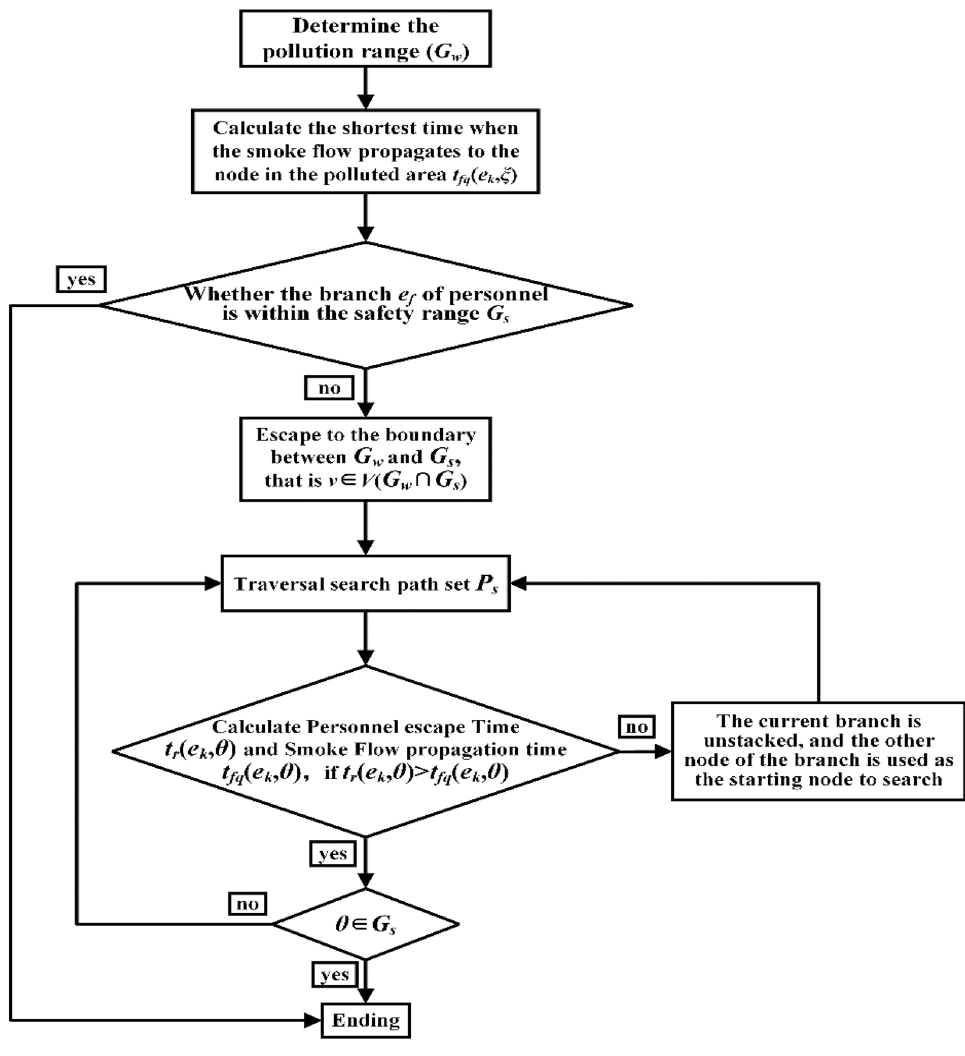
Figure 1. Numerical calculation